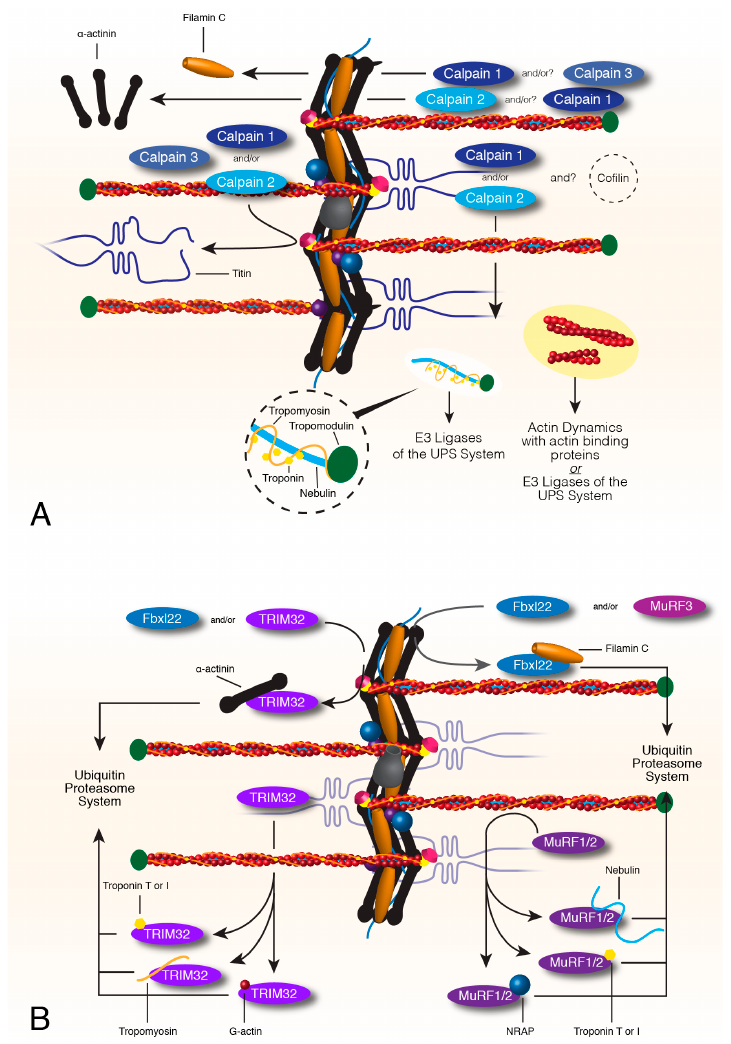
Figure 2. Calpain and Ubiquitin Proteasome Turnover of sarcomere thin filaments and associated factors. Calpains 1, 2 and 3 remove or release proteins from the complex contractile network of the sarcomere. A combination of calpains can release filamin C, actinin, titin, and the sarcomere thin